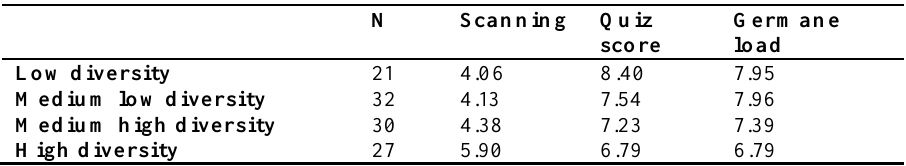
Main Variable Means by Experiment Condition